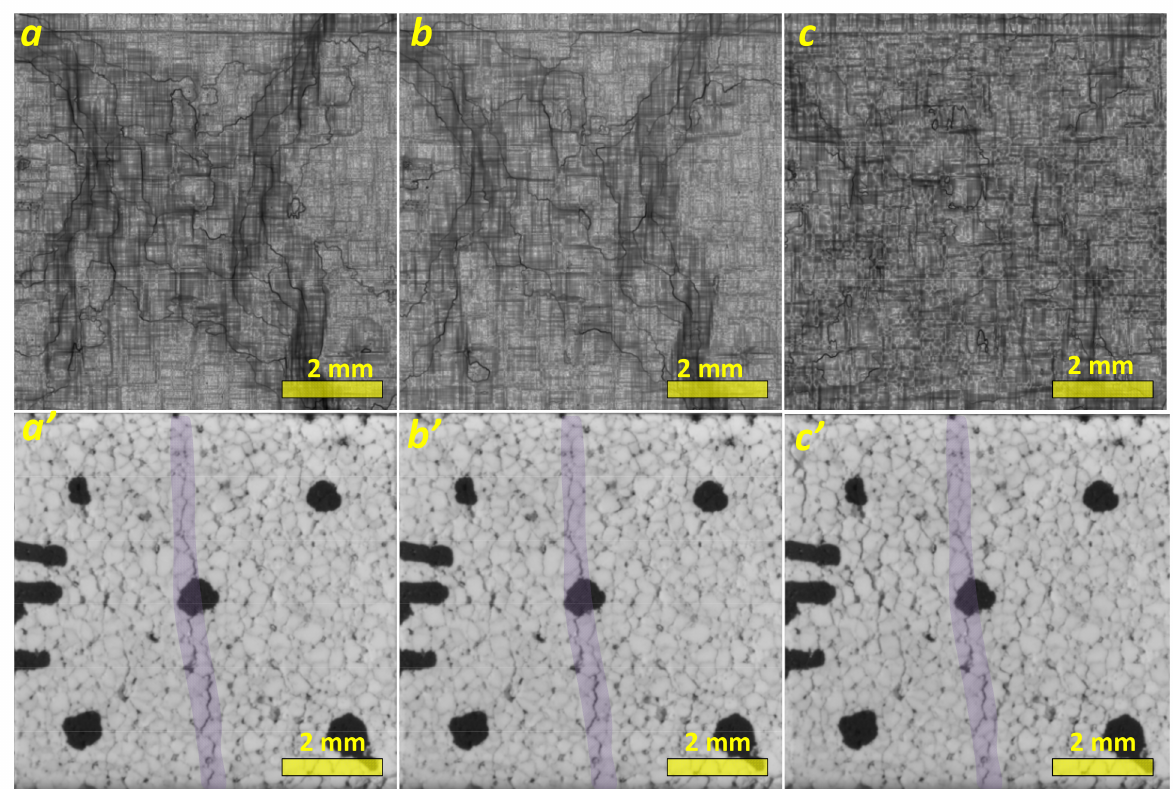
Figure 5. In-situ strain localization maps ( a – c ) and corresponding optical macrographs of segmented porous alumina ( a’ – c’ ) at strain levels as follows: ε = 0.0222, ∆ ε = 0.006 ( a ); ε = 0.0282, ∆ ε = 0.006 ( b ); and ε = 0.045, ∆ ε = 0.006 ( c